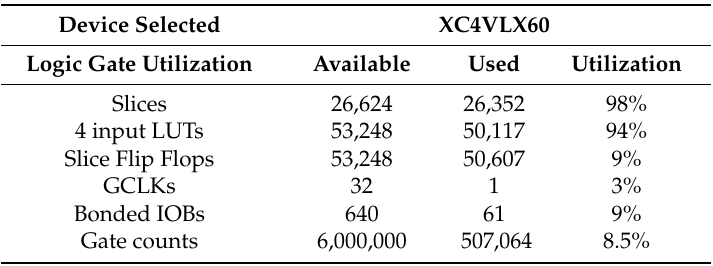
Table 3. Resources requirements of FNFN implementation for the temperature control.